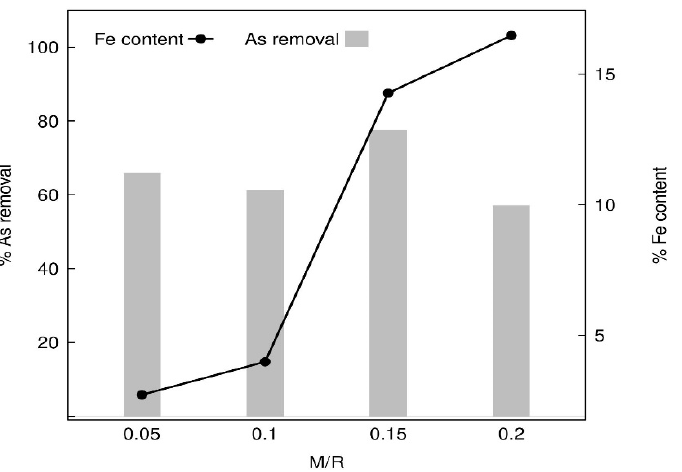
Figure 1. Fe contents on the adsorption of As(V) using magnetic xerogel monoliths (Conditions: pH = 5, contact time 24 h, dose 2 g/L (100 mg/50 mL) and As concentration 165 µg/L).